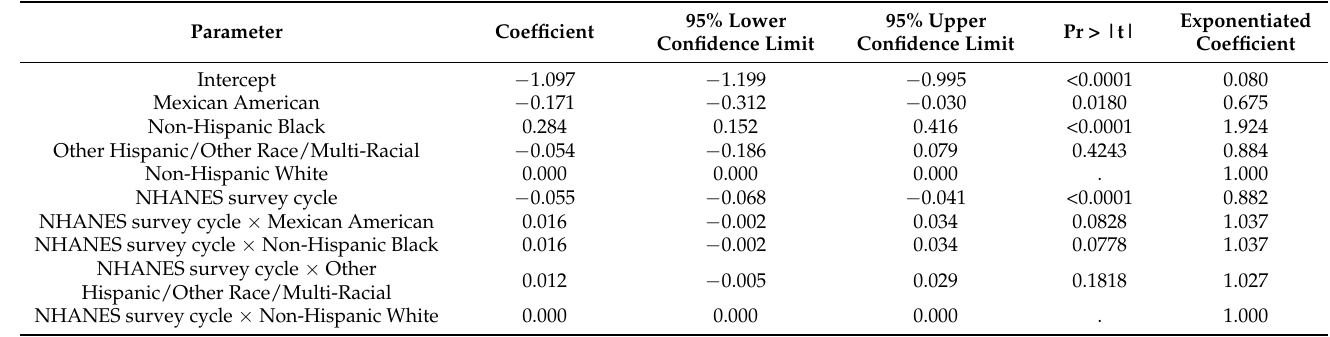
Table A5. Sample-weighted linear regression model results of serum cotinine for U.S. nonsmokers aged ≥ 3 years by race from 2003 to 2018.